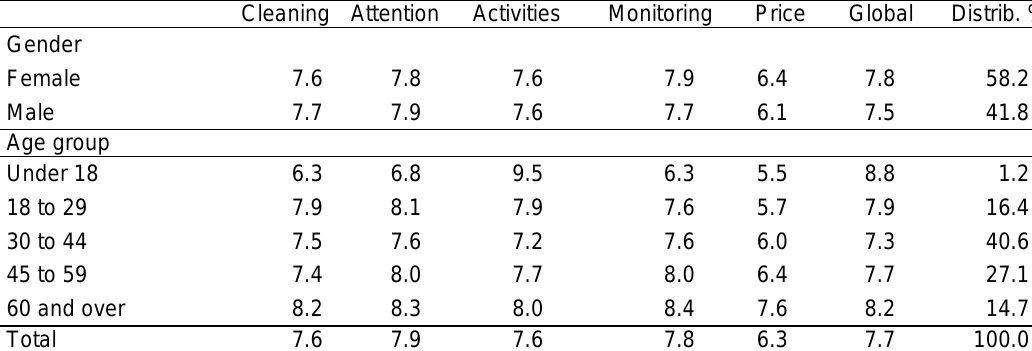
Table 14. Assessment of sports facilities by gender and age group (2017). Gornal sports facility. Cleaning